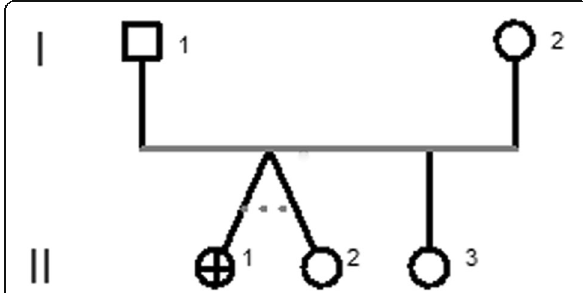
Fig. 2 Pedigree of the Italian family. Filled symbols represent affected individuals and open symbols non-affected individuals